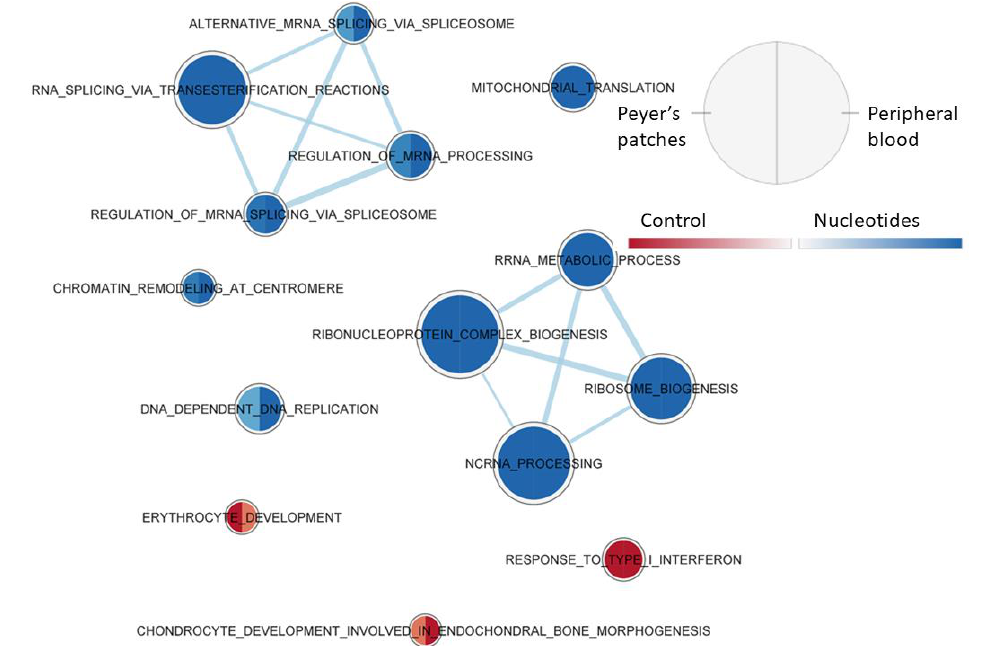
Figure 6. Effect of diet on PB and JPPs gene sets enriched at weaning (T1), using the collection of biological processes according to GO. The nodes represent the enriched gene sets in the CO group (red) and NU group (blue). For each node, the right semicircle represents the JPPs and the left semicircle represents PB. The node size represents the number of genes in each gene set. The threshold for node insertion was an FDR q-value < 0.001. The nodes were joined if the overlap coefficient was ≥0.5.